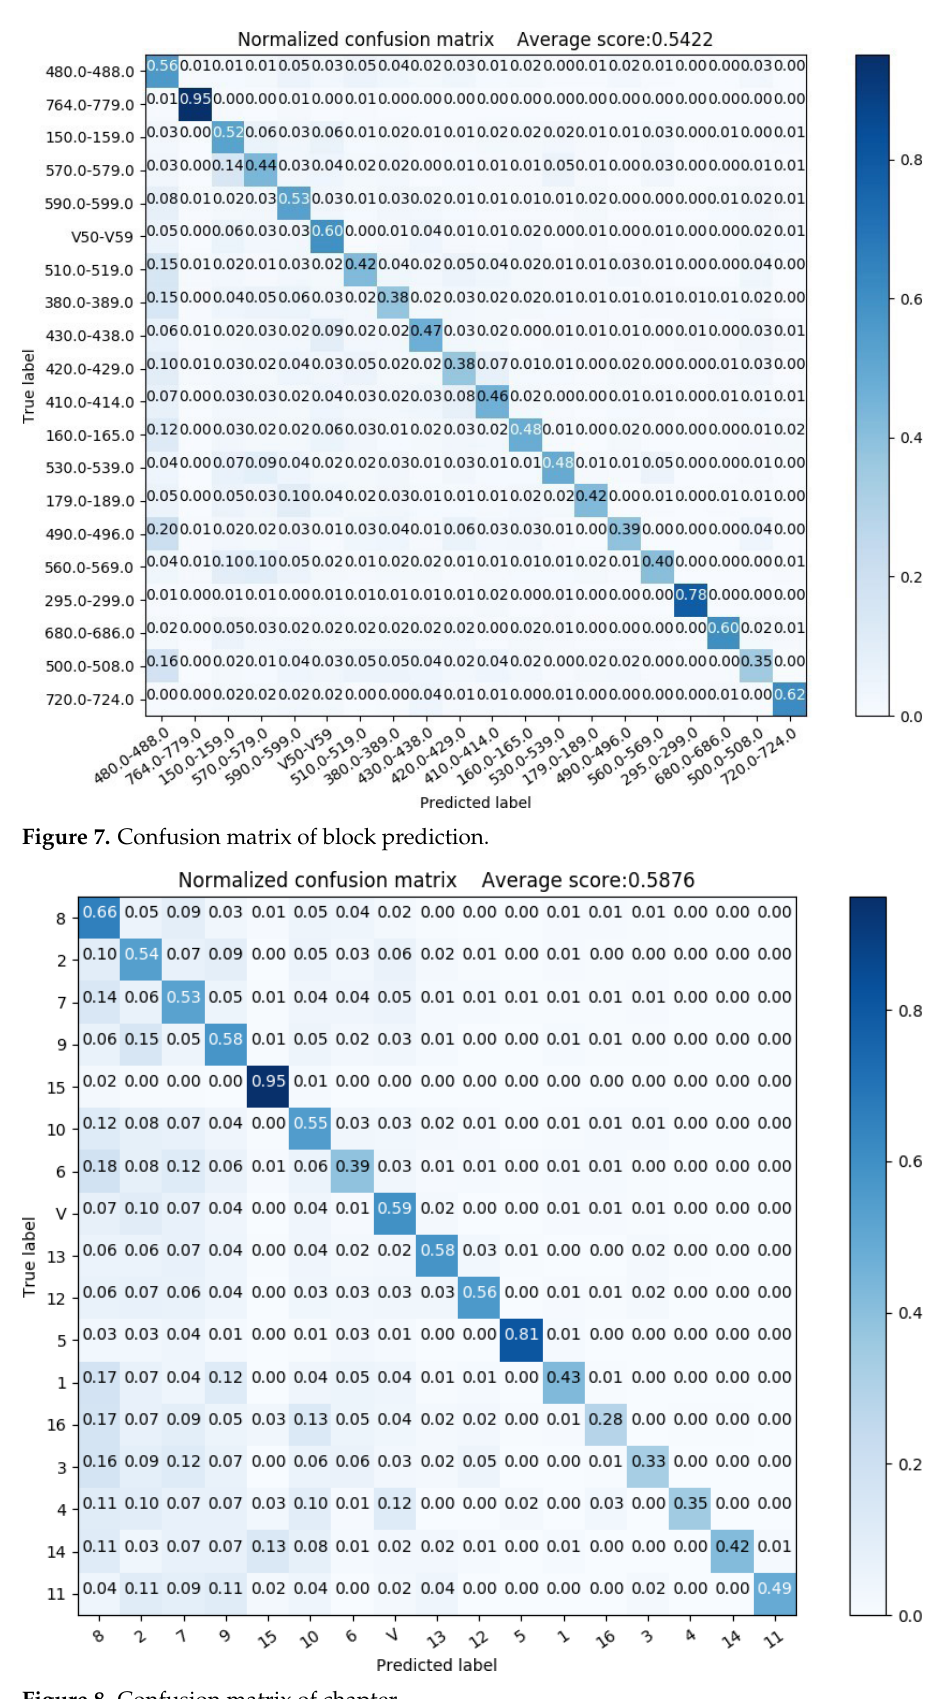
Figure 8. Confusion matrix of